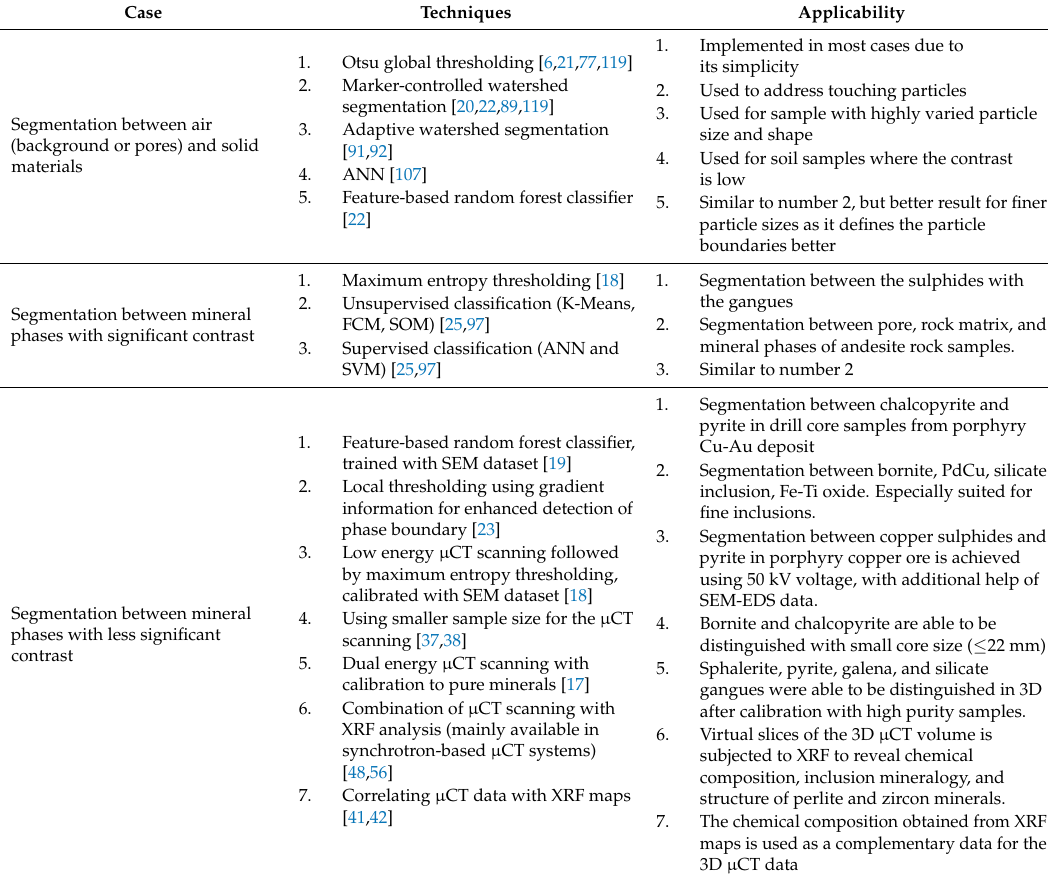
Table 2. Summary of phase segmentation techniques applied in mineral characterization using µ CT